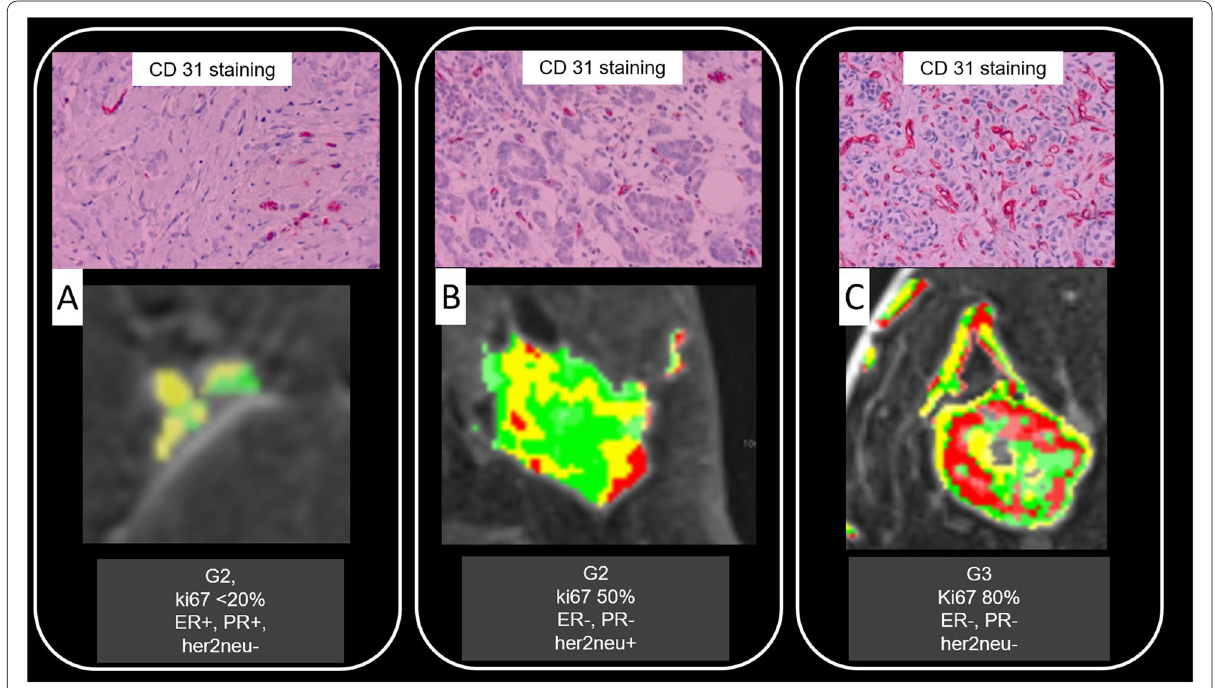
Fig. 3 Benefit of vascular analysis for predictive/prognostic breast magnetic resonance imaging. In A , B , and C , the enhancement patterns of three different breast cancers are colour coded on a pixel‑by‑pixel basis (green/yellow/red persistent/plateau/washout). The maps reveal = tumour heterogeneity, progressively increasing from A to C (no washout pixels in A , few of them in B , and many in C ). Findings correspond to an increasing risk profile which was verified upon pathological and molecular analysis. Here, increasing vascularisation (CD 31 staining top row), cellular proliferation (Ki‑67), and aggressiveness (grading) was demonstrated, and a less favourable receptor profile was evident from A to C . ER Oestrogen, her2neu Human epidermal growth factor receptor 2, PR